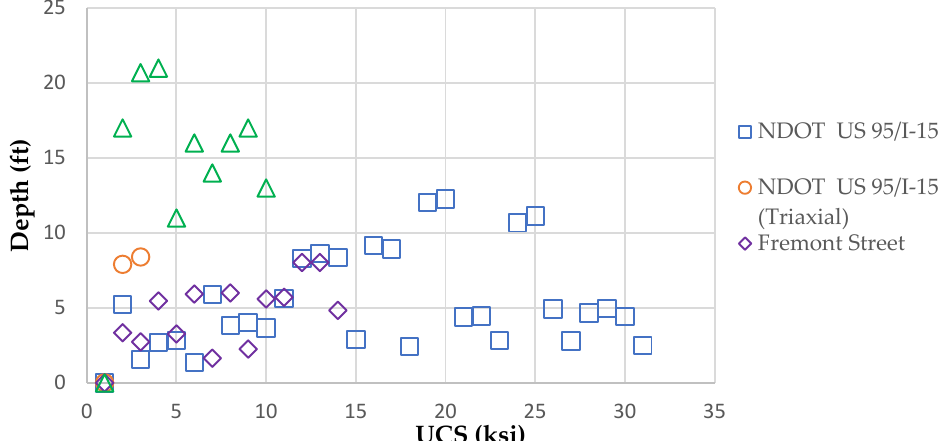
Figure 2. Measured unconfined compressive strength (UCS) triaxial test results of the caliche cores.